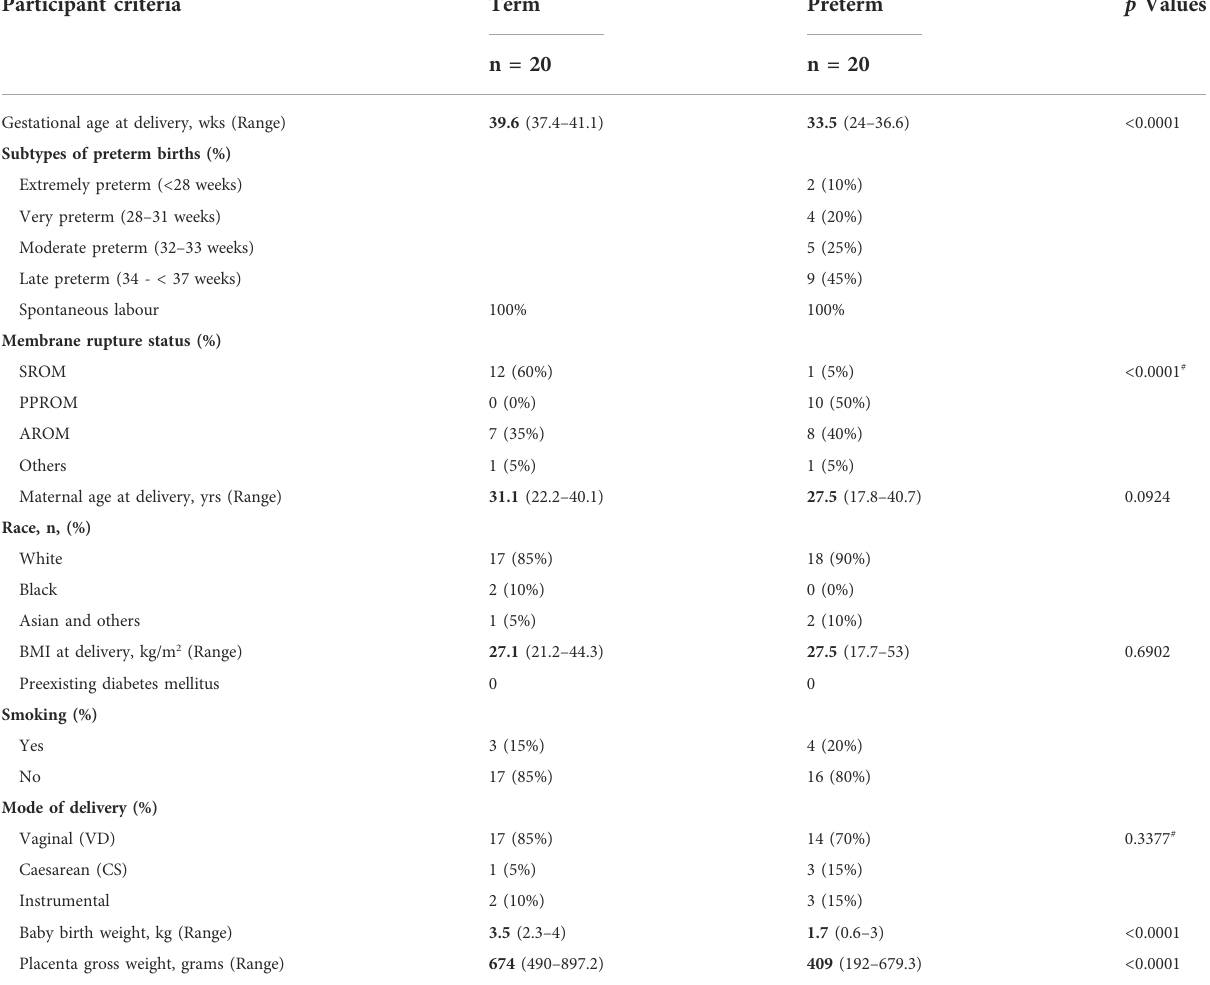
TABLE 1 The study participants criteria. Data is presented as median with ranges in the parentheses. p values are calculated by either Mann-Whitney U test or # Fisher ’ s exact